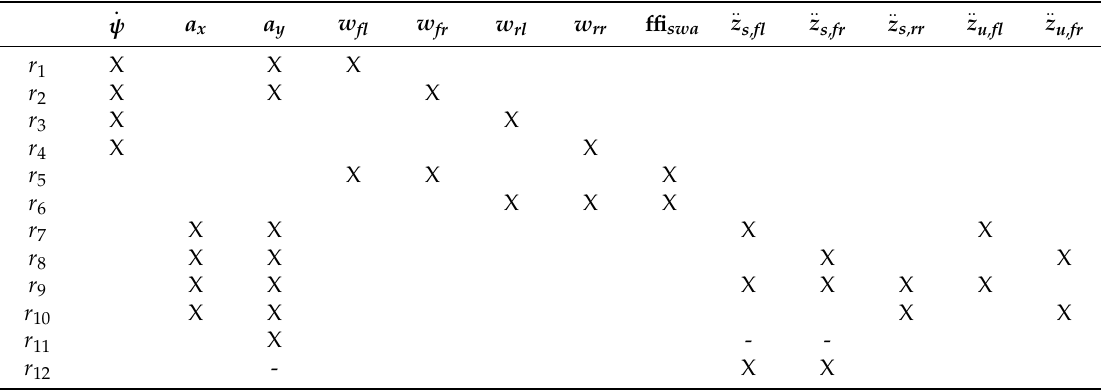
Table 5. Parameters semi-correlation table of all residuals.